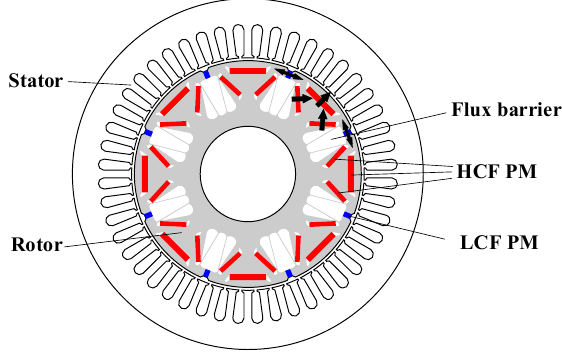
Figure 27. Delta ‐ type salient pole parallel ‐ type VFM machine with extended flux barriers [77]. Figure 27. Delta-type salient pole parallel-type VFM machine with extended flux barriers